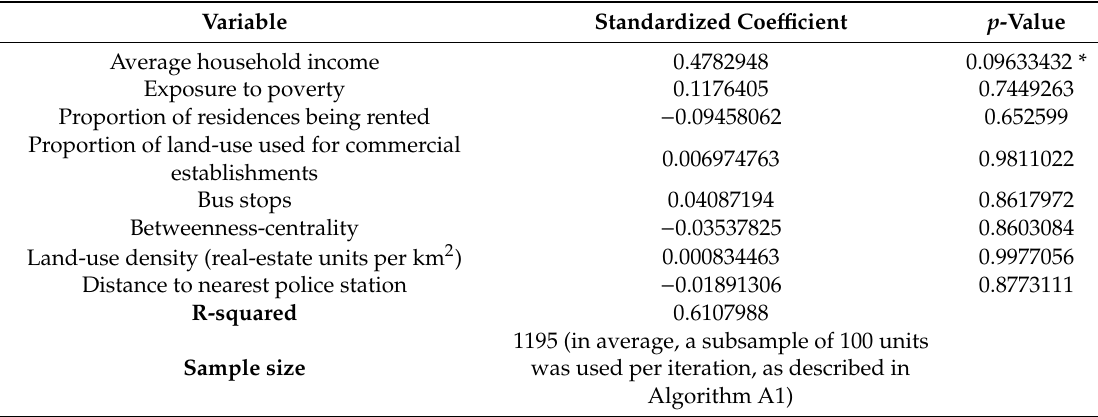
Table 5. Estimated model for burglary risk at single family houses. Regressed coe ffi cients and corresponding p -values are shown for all variables considered, using a bandwidth λ equal to 8000 m (which provided the highest fitness